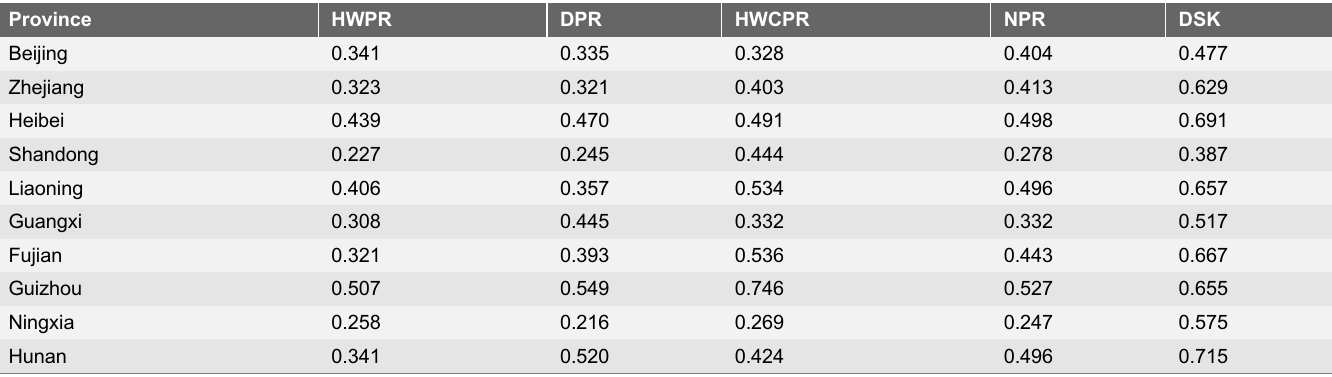
Table 3. Gini coefficients of different indicators for each province (n 5